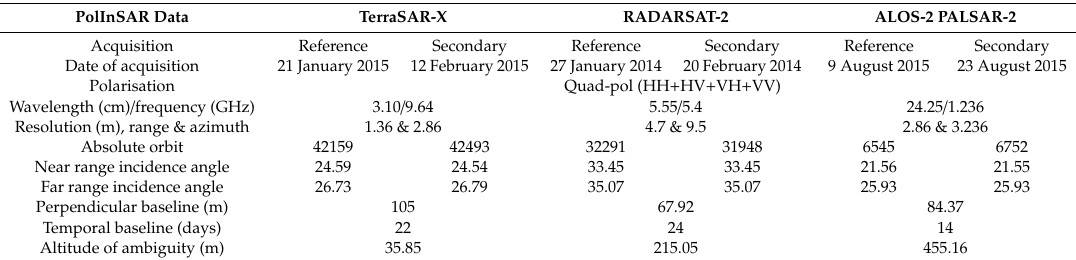
Figure 6. Polarimetric synthetic-aperture radar interferometry (PolInSAR) geometry. Table 2. Description of the multifrequency polarimetric interferometric data.